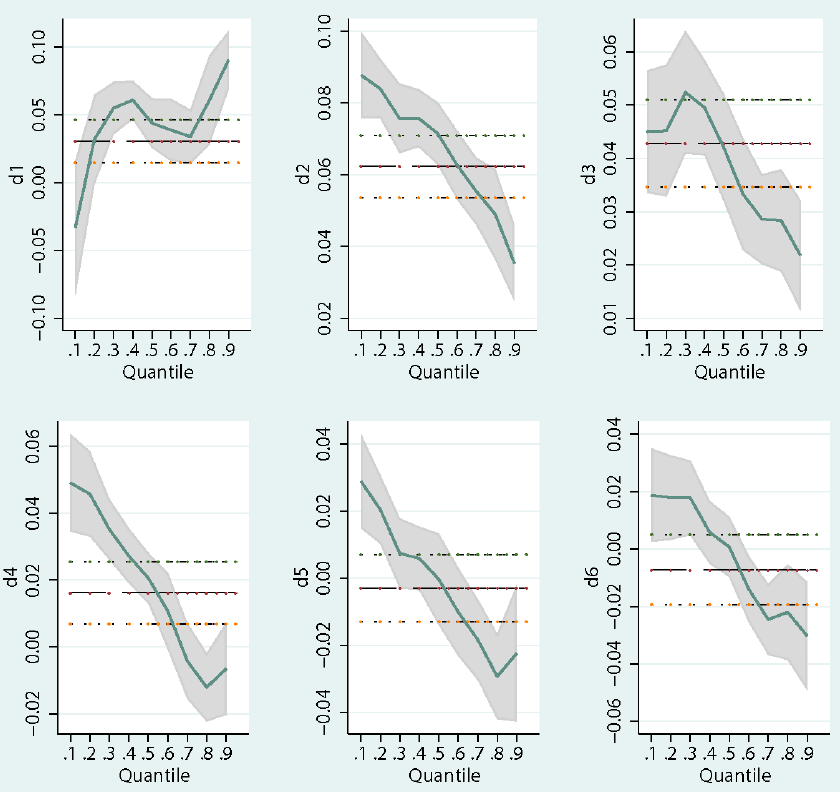
Figure 2. Changes of coefficients of d1–d6 in different quantile regression results in Equation